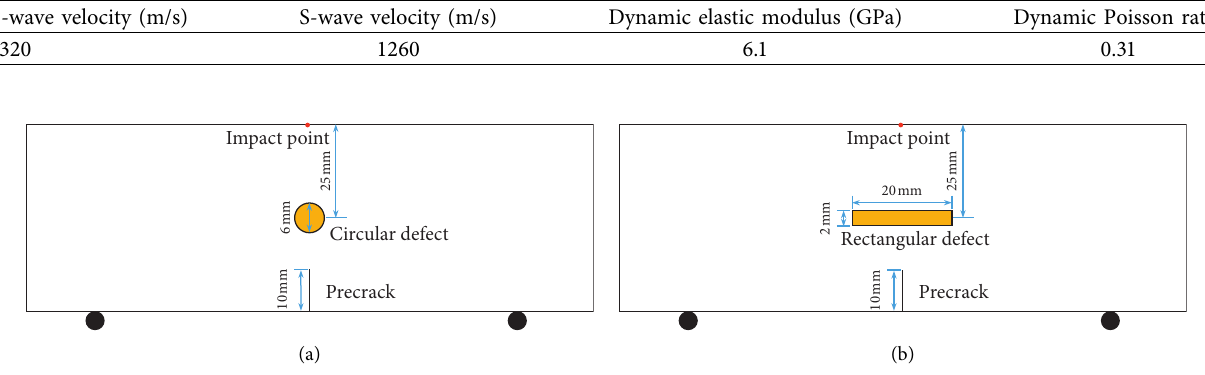
Figure 4: Diagram of the specimen containing a defect. (a) Circular defect group. (b) Rectangular defect group.